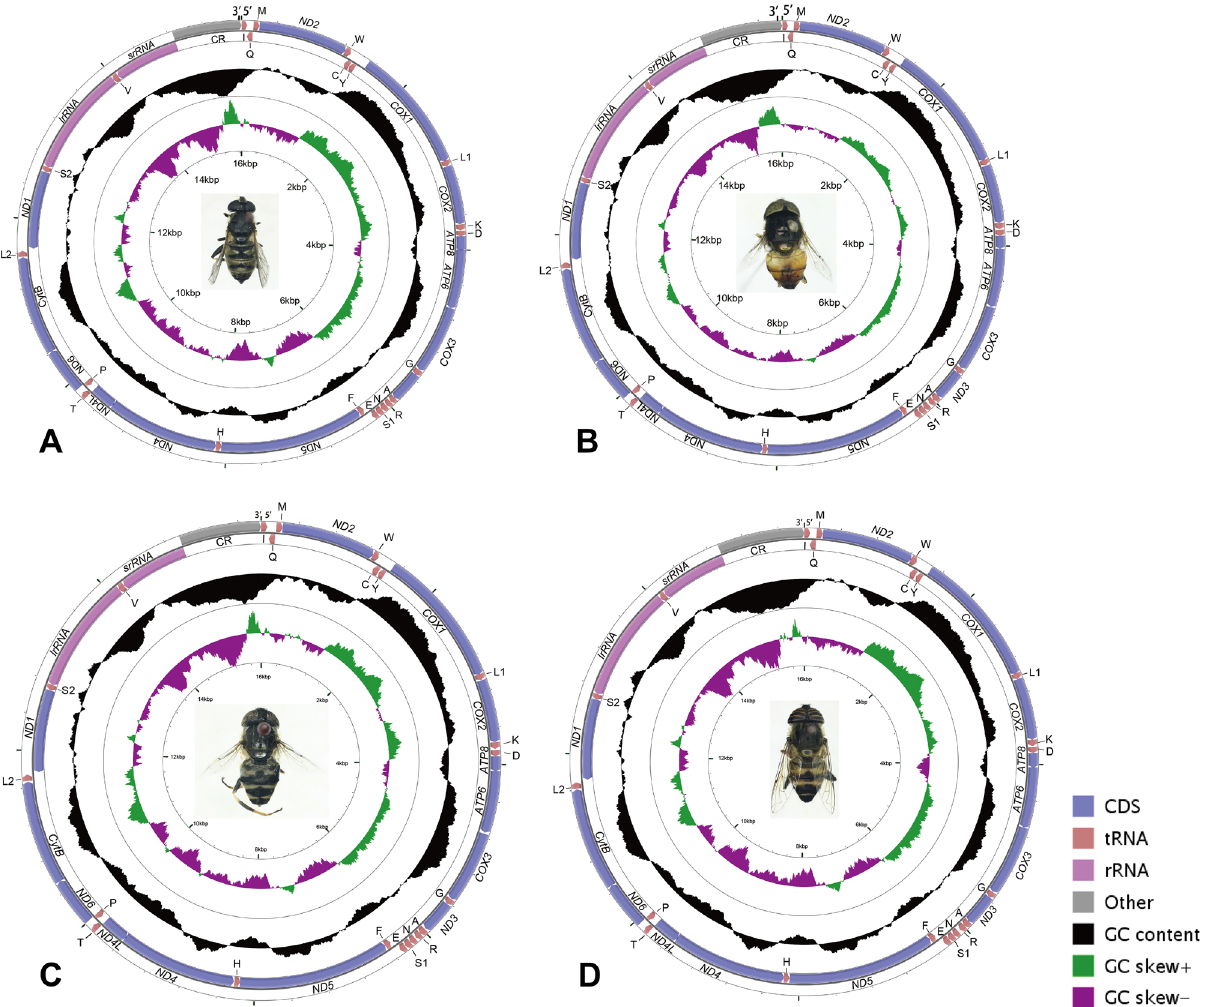
Figure 1. The circle maps of the complete mitochondrial genomes of Eristalinus . ( A ) E. viridis , 15,640 bp, ( B ) E. quinquestriatus , 15,872 bp, ( C ) E . tarsalis , 15,849 bp, ( D ) E. sp., 15,883 bp. PCGs, tRNAs, rRNAs have been given, CR represented control region. The arrow indicates the direction of the gene from start to end. A black pattern shows GC content: four species, pictures taken by Juan Li using CG view (http:// stoth ard. afns. ualbe rta. ca/ cgview_